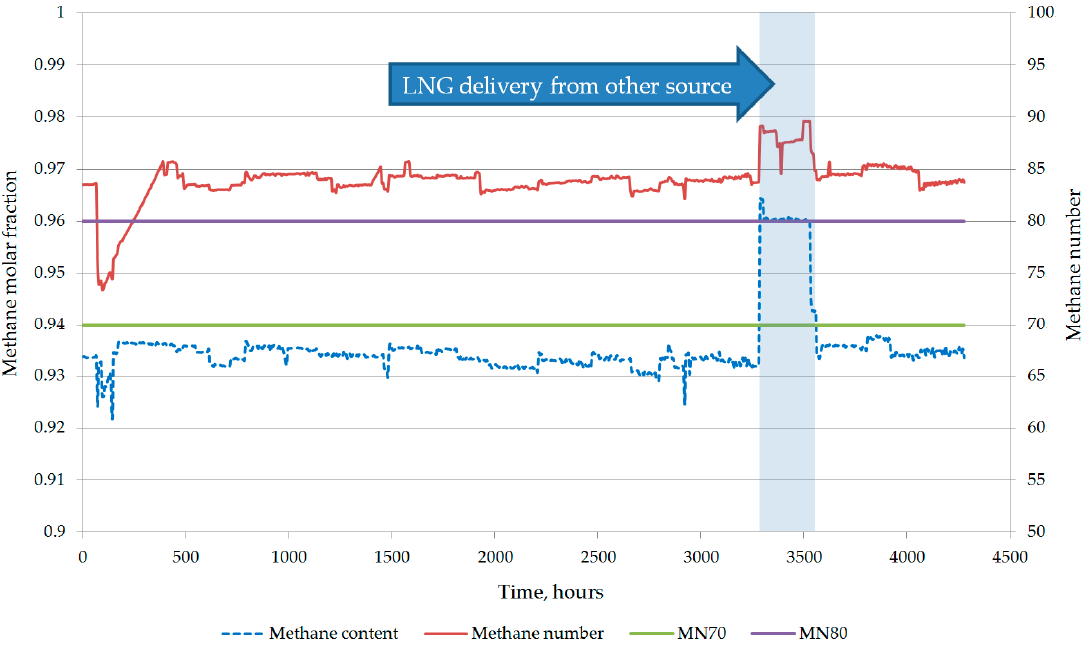
Figure 12. Methane number and methane content changes in exemplary operational conditions at LNG Terminal.